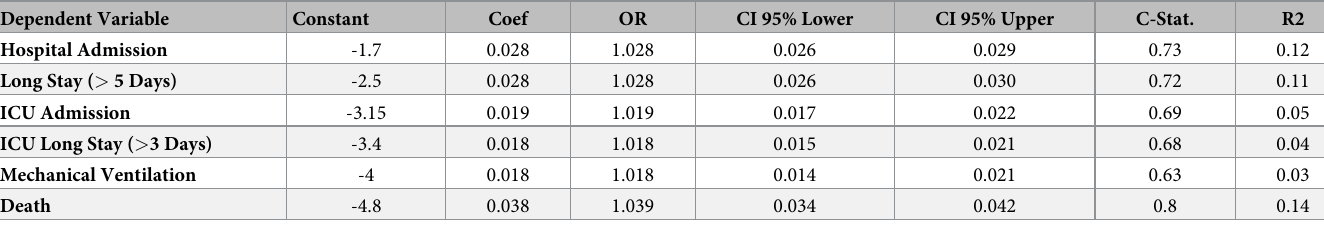
Table 3. Results of logistic regression model parameters for CAN score greater than